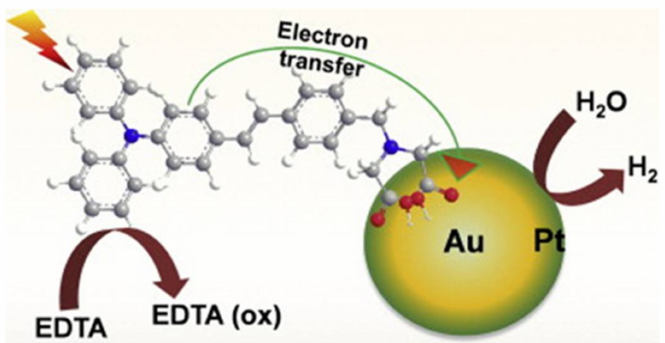
Figure 6. Schematic representation of electron transfer from a triphenylamine derivative, 2,2 (cid:48) -(4-(4-(diphenylamino) styryl) benzylazanediyl) diacetic acid (TPAD) sensitizer into an Au core–Pt shell nanoparticle and photoinduced hydrogen evolution under light irradiation